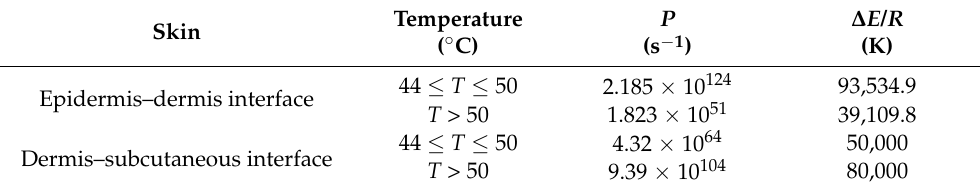
Table 1. Values of P and ∆ E/R in the Henriques burn integral [34].